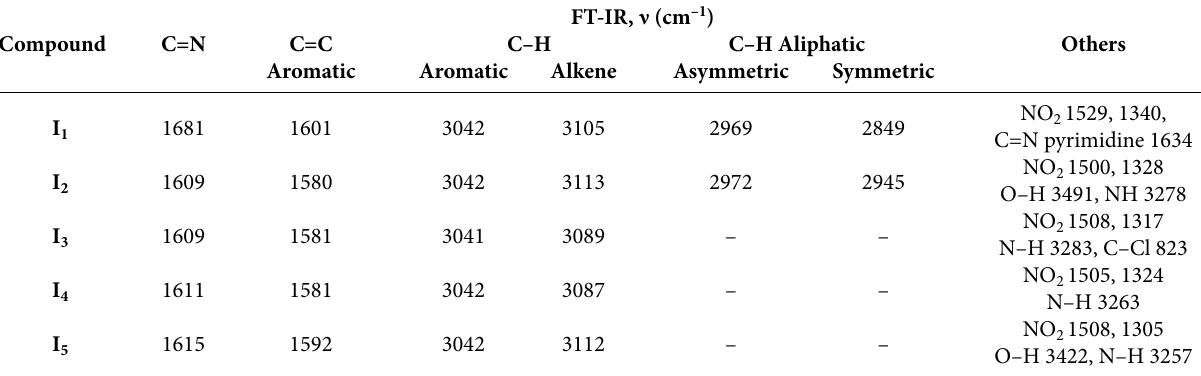
Table 3. FT-IR of azomethine compounds I 1 – I 5